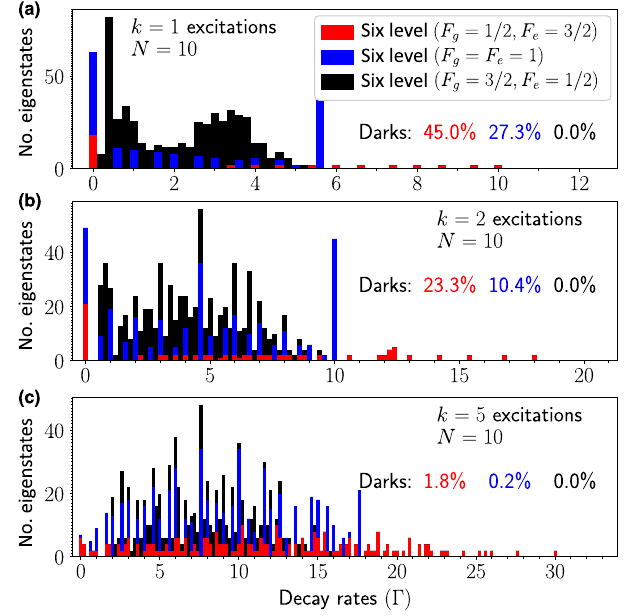
FIG. 15. Six-level collective eigenstates. Histograms of the decay rates ( γ = Γ ) of all collective eigenstates with (a) k ¼ 1 , (b) k ¼ 2 , and (c) k ¼ 5 excitations for N ¼ 10 . We show results 1 = 2 , F 3 = 2 , (blue) for six-level systems with (red) F g ¼ e ¼ 1 , and (black) F 3 = 2 , F 1 = 2 . We provide in F F g ¼ e ¼ g ¼ e ¼ the plots the percentage of eigenstates that are dark for each k and level structure in the associated color. Note that the histograms are stacked on top of each